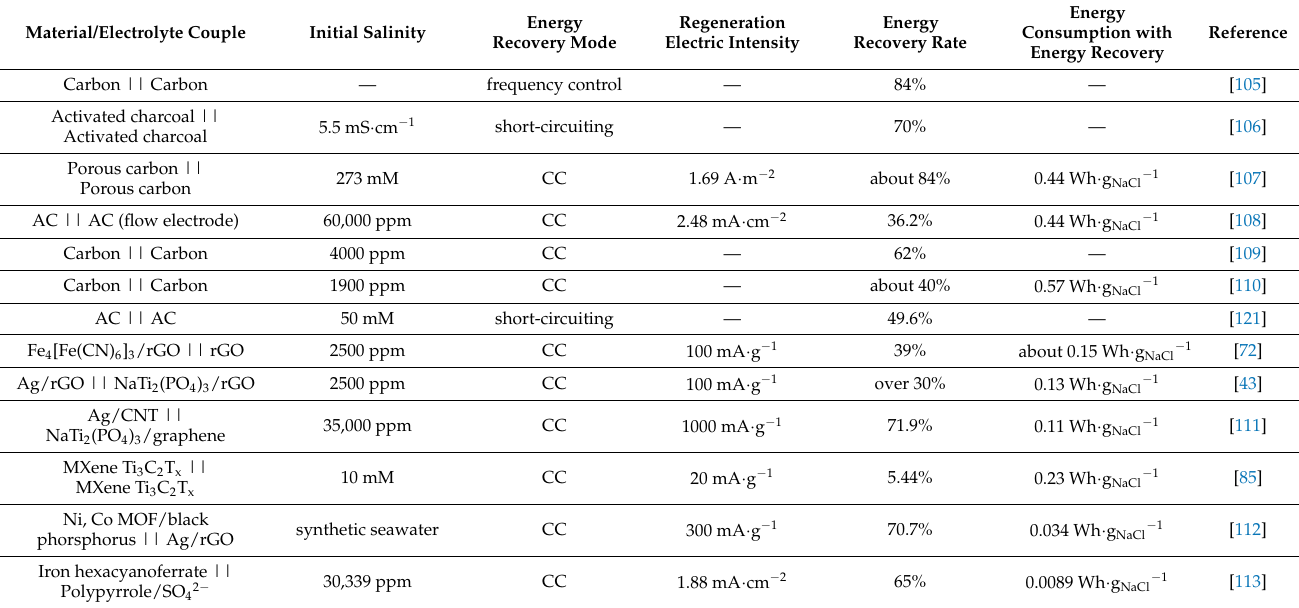
Table 2. The energy recovery performances of different CDI